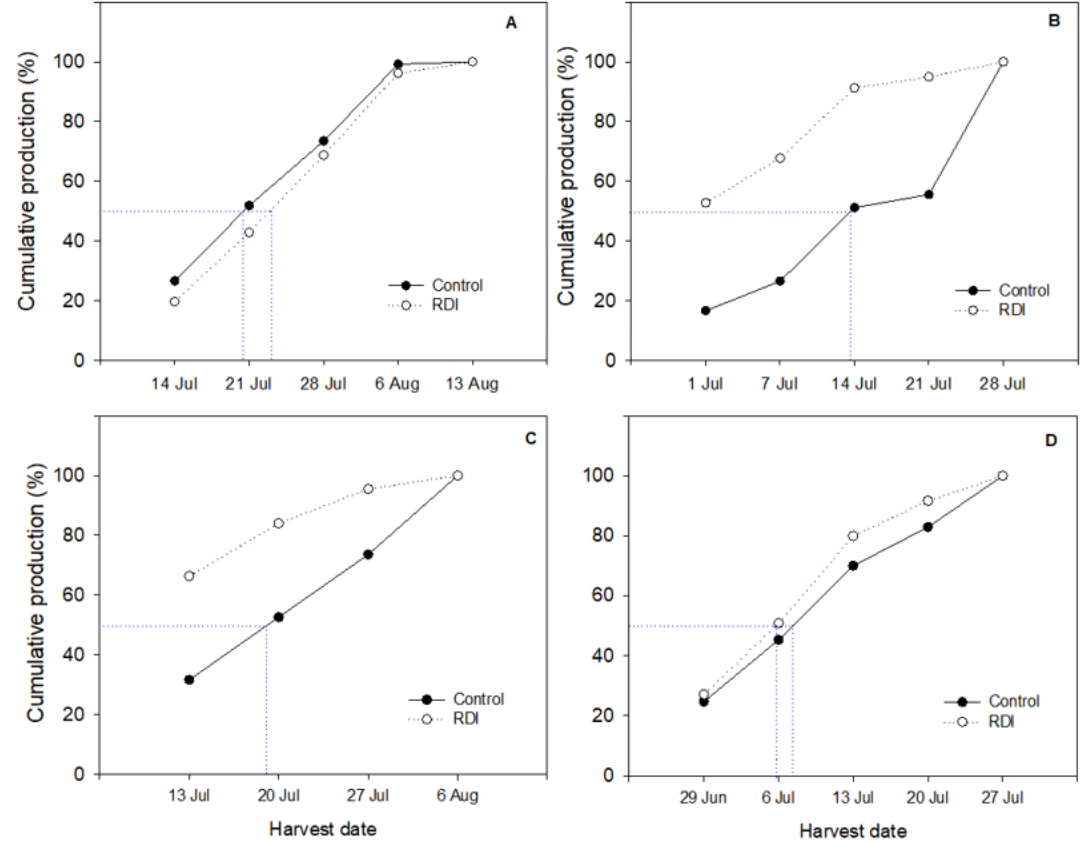
Figure 5. Cumulative production in control versus regulated deficit irrigated (RDI) “Flame Seedless” vines grown under net (A and C) and plastic greenhouse (B and D) in 2015 (top) and in 2016 (bottom).